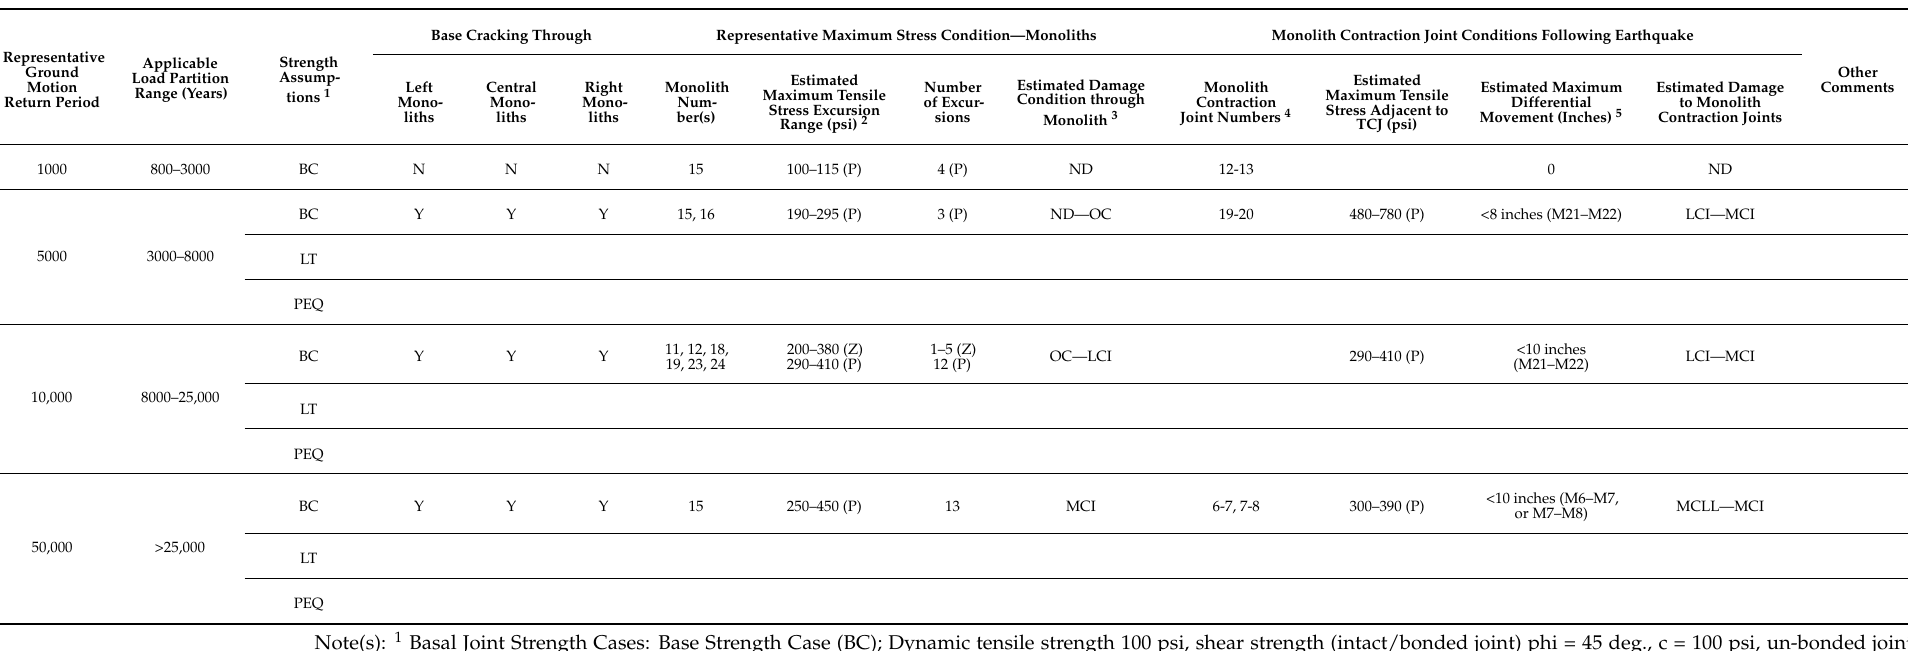
Table A6. Summary of study case results for risk analysis—monolith stresses and damage estimated from 3D model—SRCH10 (long duration CSZ ground motion). Column 2 shows the seismic load partition range used in the Risk Analysis for which the representative ground motion return period (shown in Column 1) was used to assess the performance of the